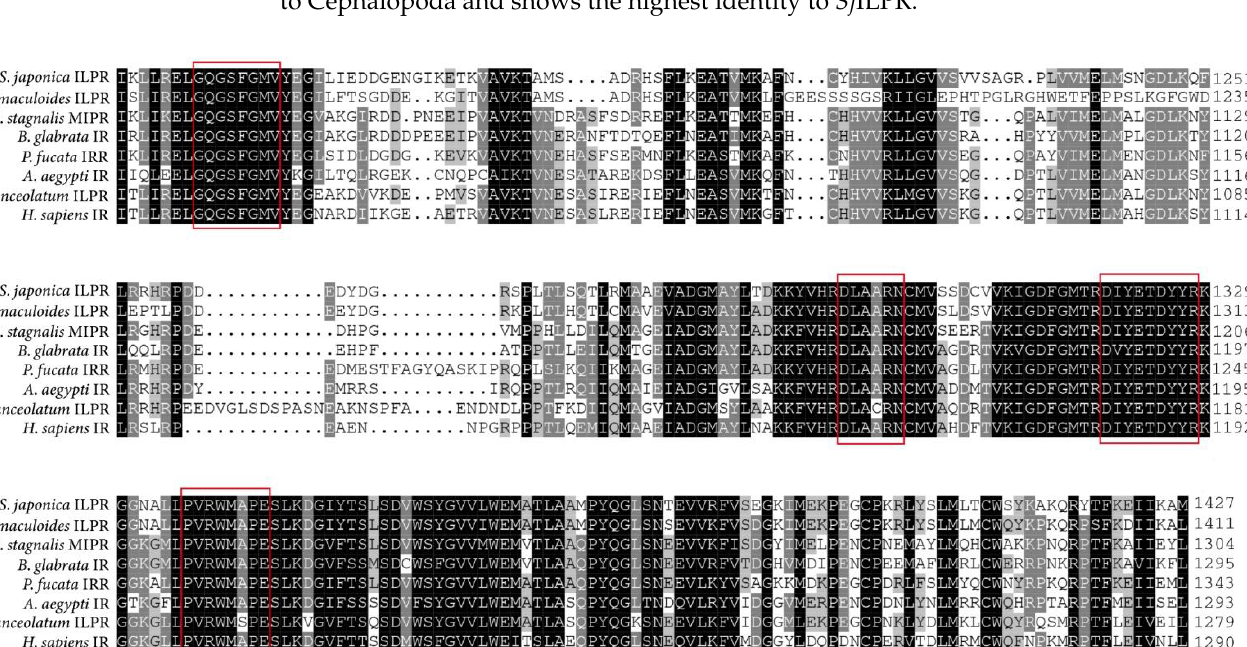
Figure 1. Amino acid sequence ( A ), structural feature ( B ), and three-dimensional (3D) structure ( C ) of SjILPR . ( A ) The dibasic site KR is highlighted in red script. The transmembrane domains are shown in white script on blue background. Indicated are the ‘L1– Cys – L2 ’ structure (gray back- ground), three fibronectin III domains (light green background), and the tyrosine kinase domain (light blue background). Juxtamembrane NPEY motif is highlighted in the red script and under- lined. Catalytically important residues of the TK domain are highlighted in red script and black rectangles. ( B ) Smart domain architecture of SjILPR : the blue rectangle depicts the transmembrane domain; Recep_L_domain indicates the receptor L domains; FU, furin-like repeats; FN3, fibronectin type 3 domain; and TyrKc, the tyrosine kinase catalytic domain. ( C ). The predicted 3D structure of SjILPR , is structurally based on Homo sapiens insulin receptor.